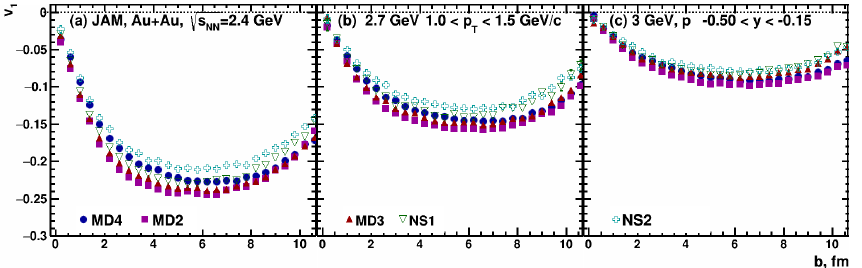
Figure 19. Impact parameter dependence of directed flow v 1 of protons in the transverse momentum interval 1.0 < p T < 1.5 GeV/c and rapidity interval -0.5 < | y cm | < -0.15 from Au + Au collisions at beam √ s NN = 2.4 GeV (panel ( a )), 2.7 GeV (panel ( b )), and 3.0 GeV (panel ( c )). Different symbols energies correspond to the different EOS implementations in the JAM model: soft momentum independent NS2 ( K 0 = 210 MeV), hard momentum independent NS1 ( K 0 = 380 MeV), soft momentum dependent MD4 ( K 0 = 210 MeV) and hard momentum dependent MD2 and MD3 ( K 0 = 380 MeV).